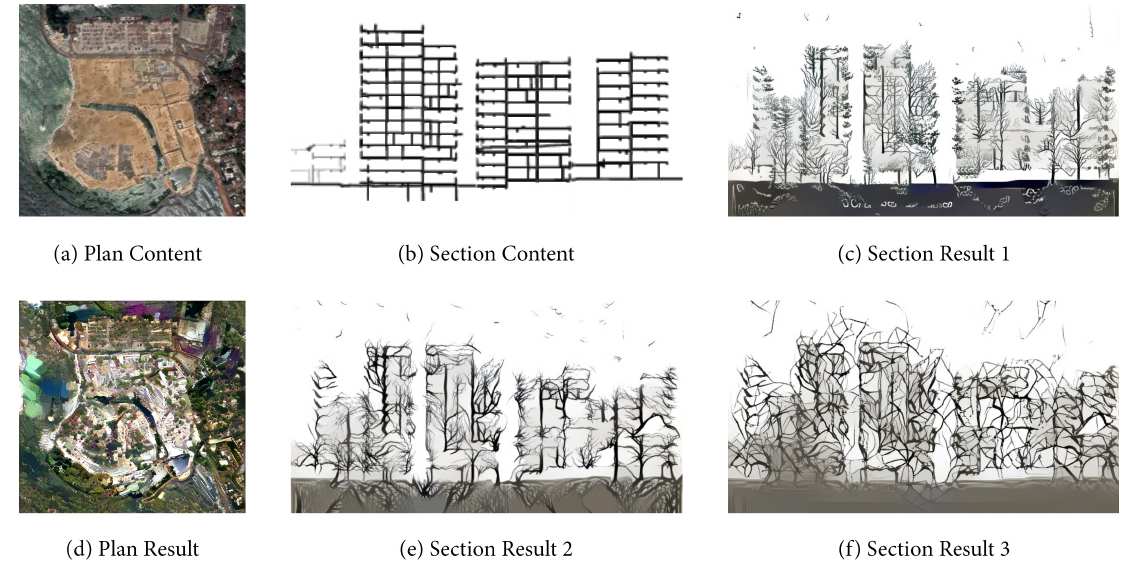
Figure 7. These are single plan and section drawing training examples through “neural style transfer”: ( a ) Plan content input. ( b ) Section content input. ( c ) Section generated output 1. ( d ) Plan generated output. ( e ) Section generated output 2. ( f ) Section generated output